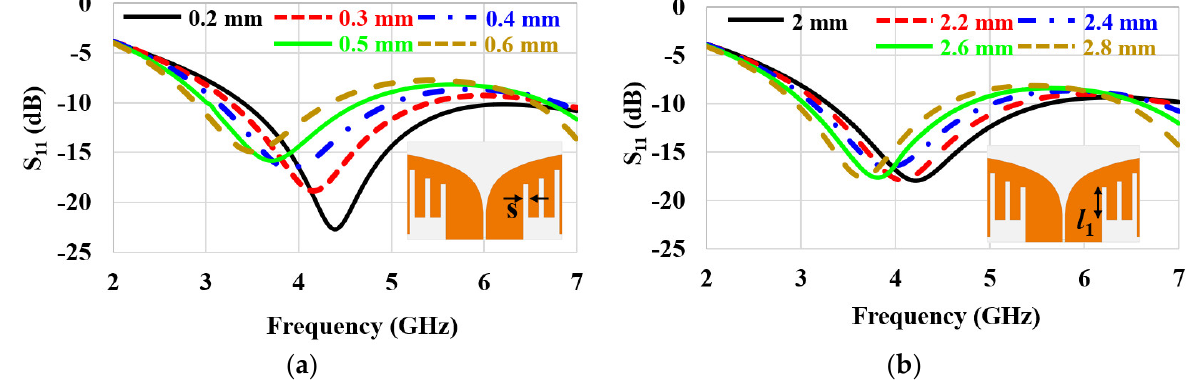
Figure 6. Parametric studies of S 11 by varying ( a ) slot width s and ( b ) slot length l 1 .